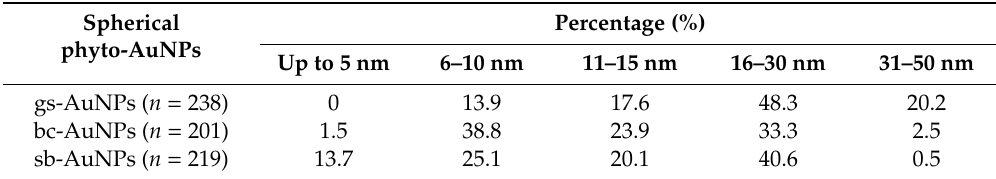
Table 4. Characteristics of spherical phyto-AuNPs fractions synthesized using leaf extracts from gooseberry, blackcurrant and strawberry (based on TEM